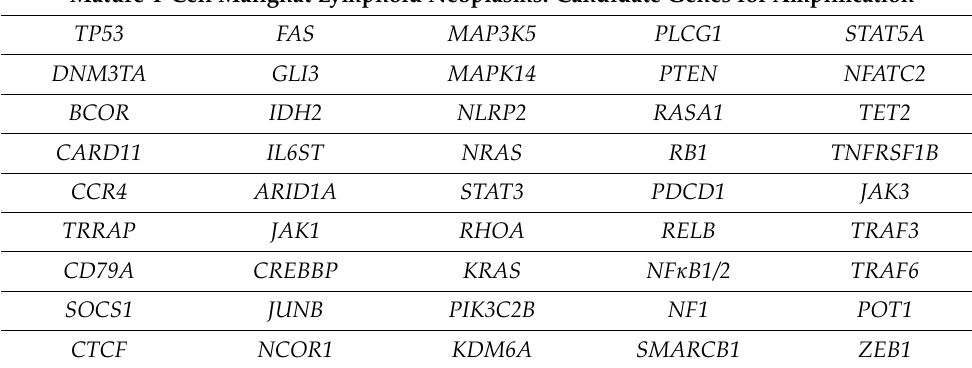
Table 2. Proposal for an ampliseq panel of genes for mature T-cell malignant neoplasms [30]. Mature T-Cell Malignat Lymphoid Neoplasms: Candidate Genes for Amplification